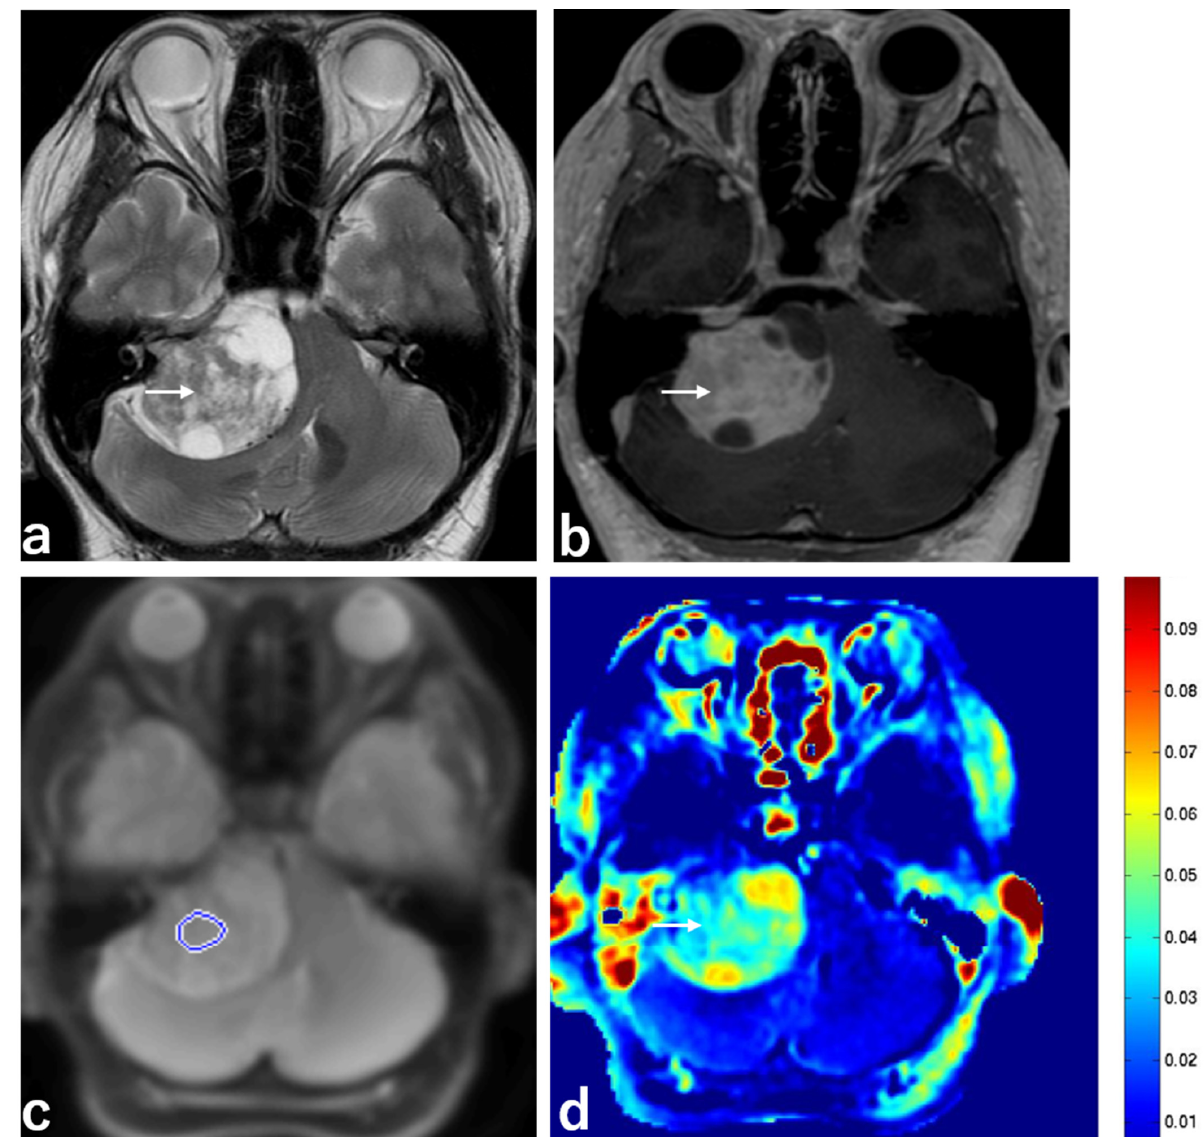
Figure 1. Imaging from a 43-year-old man with a schwannoma with T2 hyperintensity. ( a ) MRI, T2 sequence, axial section, showing heterogeneous high intensity in a schwannoma in the right cerebellopontine angle (CPA) (white arrow). ( b ) MRI, 3D contrast-enhanced T1 sequence, axial section, showing heterogeneous enhancement in a schwannoma in the right CPA (white arrow). ( c ) MRI, APT-CEST scout image, axial section, showing the ROI (blue circle) in a schwannoma in the right CPA. ( d ) MRI, APT-CEST sequence, axial section, showing high SI in a schwannoma in the right CPA (white